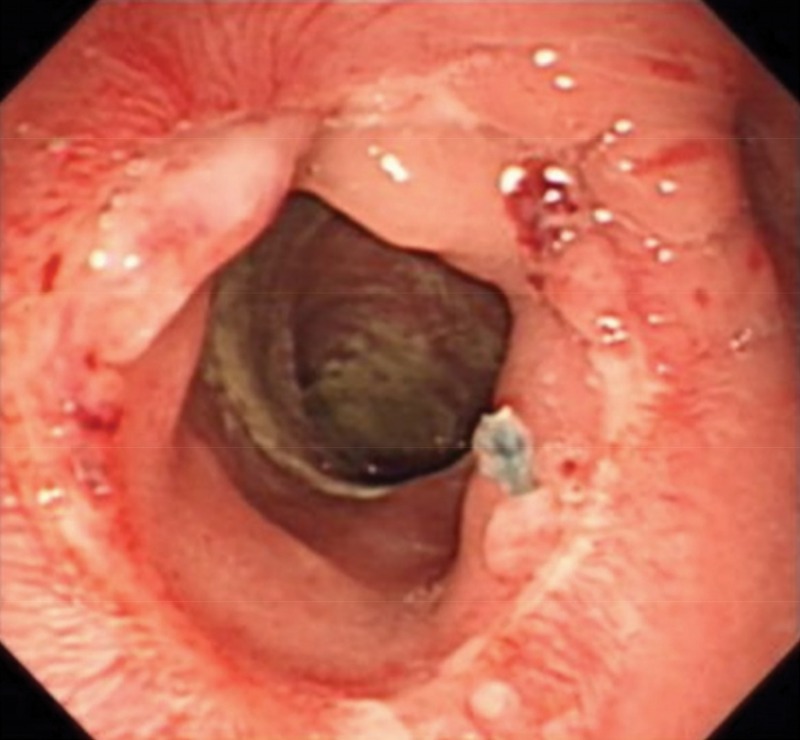
The electronic colonoscopy view of the smooth anastomosis after 3 months postoperatively.